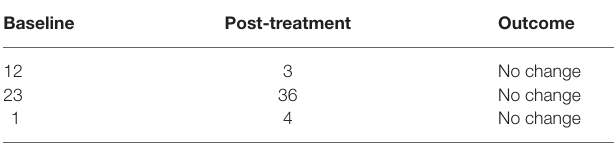
TABLE 5 | DASS-21 scores for participants at baseline and post-treatment.